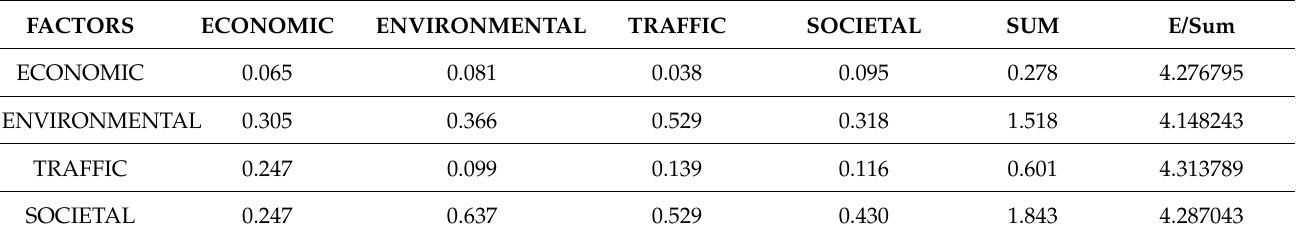
Table 7. Representation of the priority weight of factors.